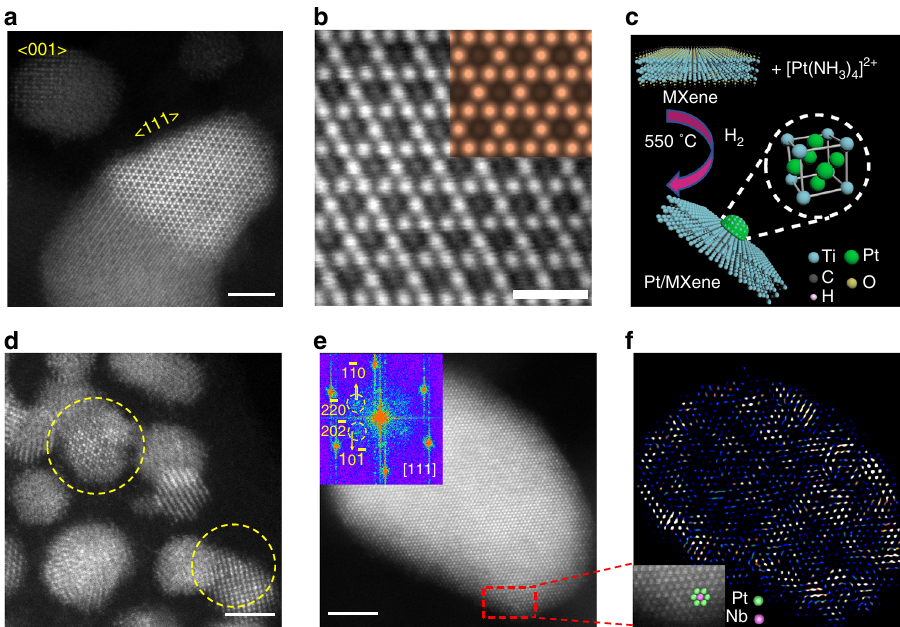
Fig. 2 Microscopy characterizations of 1% Pt/MXene catalysts. a Representative HAADF-STEM image of 1% Pt/Ti 3 C 2 T x catalyst. b (111) surface of Pt 3 Ti NP. Inset is a simulated STEM image of Pt 3 Ti (111) surface. The simulated image is in good agreement with the experimental result. c Schematic illustration of RMSI in Pt/MXene catalysts and the structure of L1 2 -ordered intermetallic Pt 3 Ti. d Representative HAADF-STEM image of 1% Pt/Nb 2 CT x catalyst. e A Pt-Nb NP viewed along [111], inset is the FFT pattern of the NP. f IFFT pattern of the NP in Fig. 2e, inset is an enlarged image showing the super lattice of the NP. Scale bars: a , d , e 2 nm, and b 500